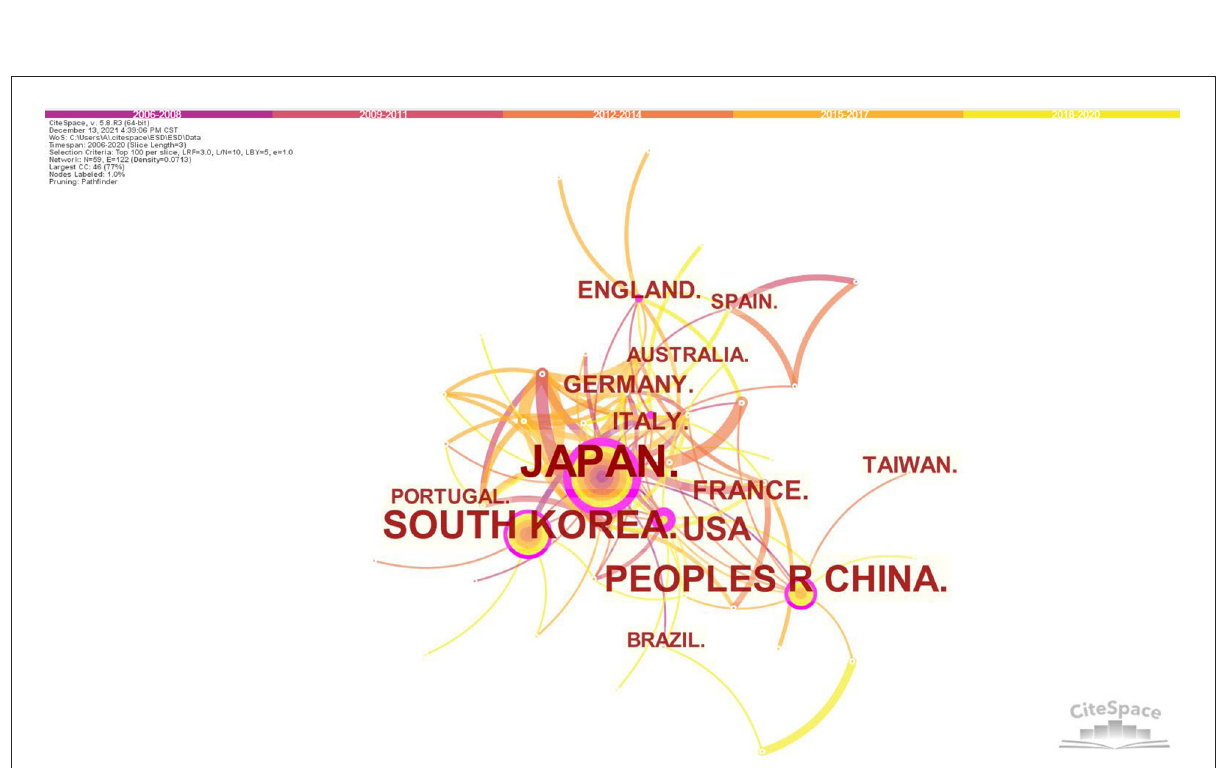
FIGURE2 Map of countries/regions cooperative relations in research of ESD, 2006-2020. The bigger the circle, the more original articles the country/region published. The shorter and thicker the connection line, the closer the relationship between countries/regions.